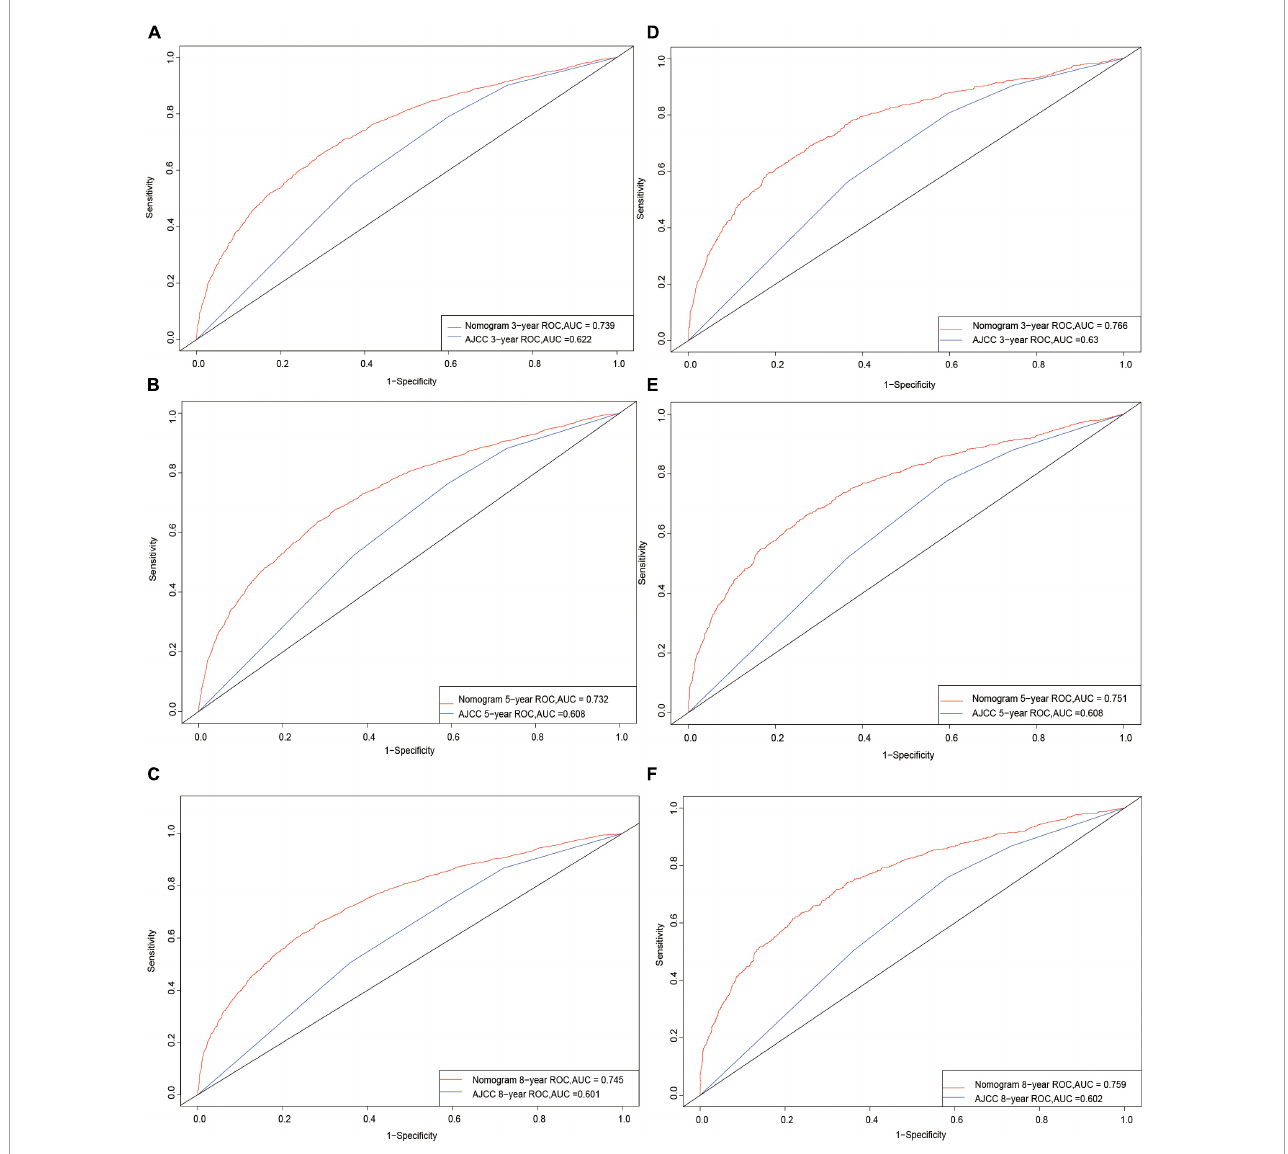
FIGURE3 Receiver operating characteristic curves. The area under the ROC curve (AUC) for 3-, 5-, and 8-year CSS probability of the training cohort (A–C) and validation cohort (D–F)